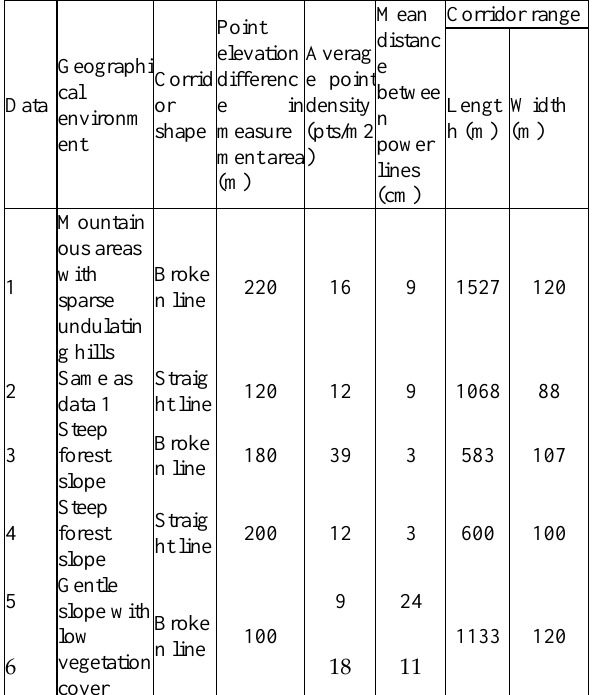
Table 2. Data characteristics of each study area.